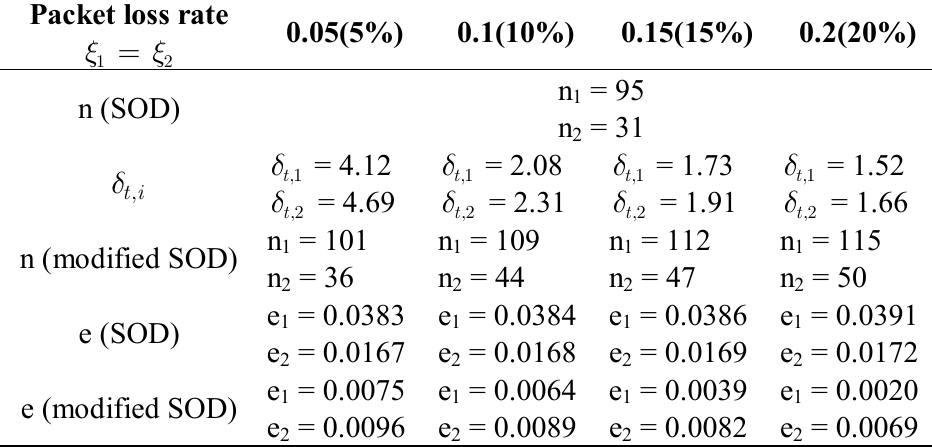
Table 1. Estimation error along with packet loss rate in two